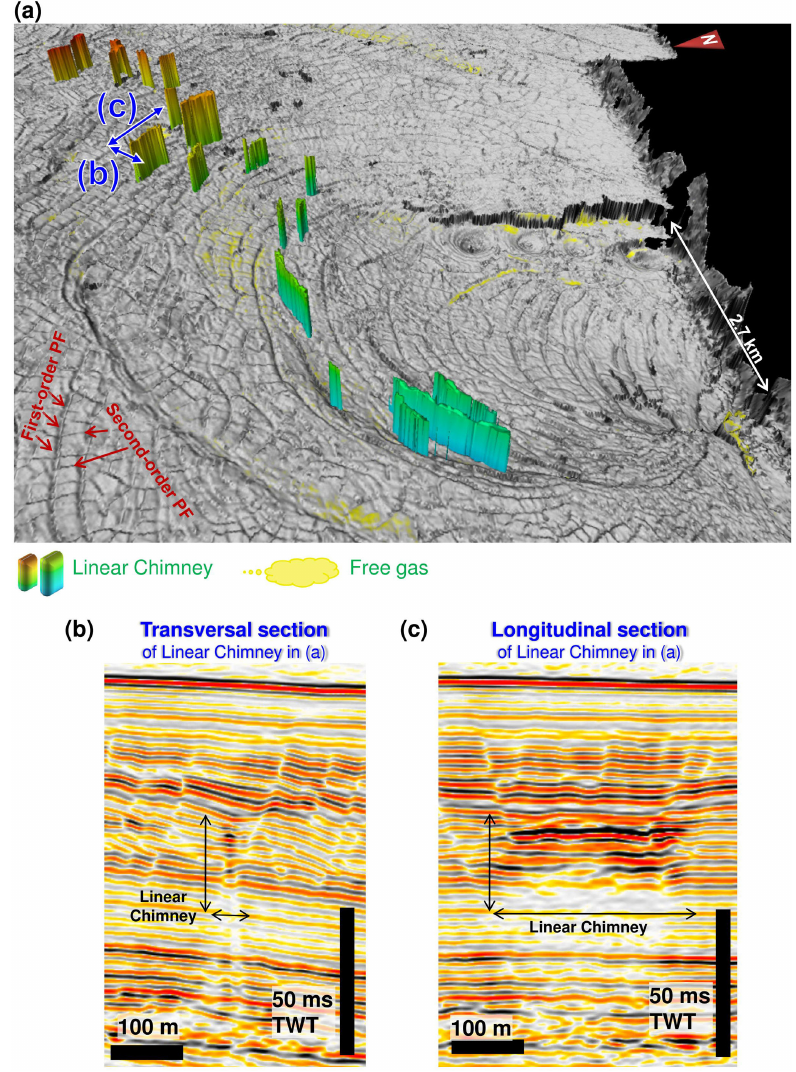
Figure 5. Morphology of Linear Chimneys. (a) 3-D visualisation of Linear Chimneys in Syncline-3 parallel to preferentially and concentri- cally orientated polygonal faults parallel to syncline edge. The 3-D chimney bodies are issued from the 3-D mapping of the high-amplitude anomaly columns on seismic sections. (b) and (c) show transverse and longitudinal seismic sections through the Linear Chimney in (a)